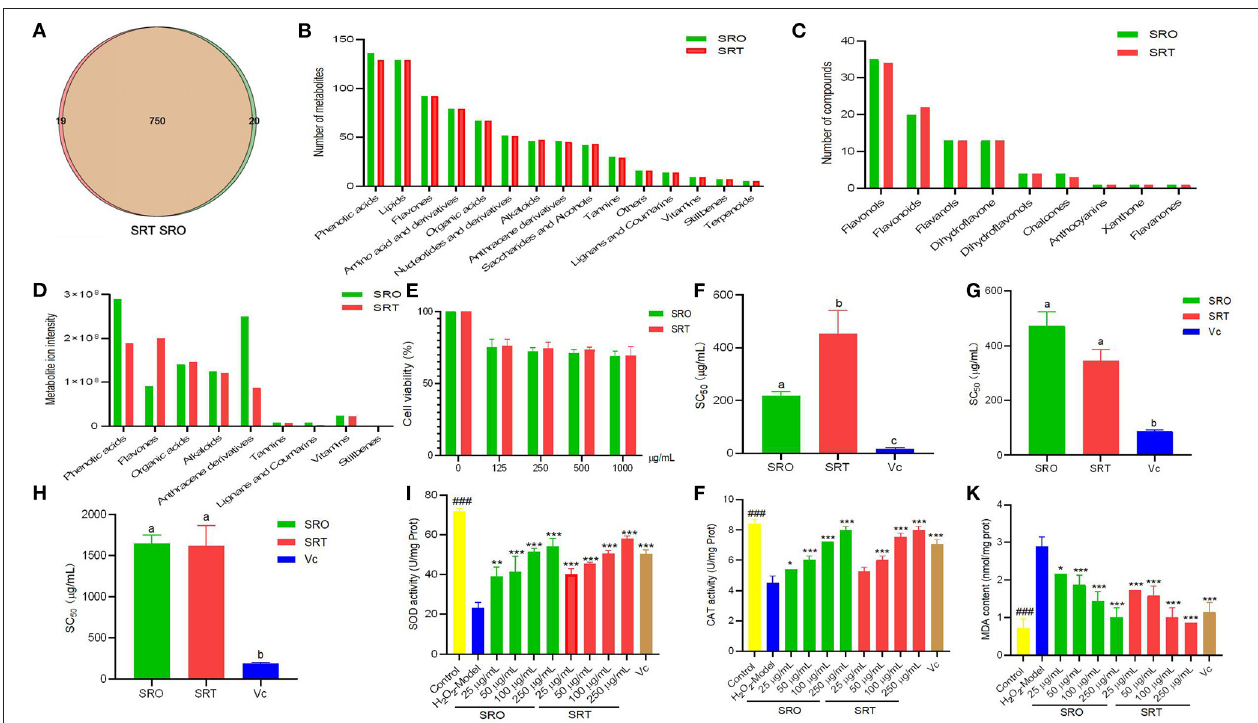
FIGURE 2 | The number of compounds (A) , metabolites (B) , and flavones (C) in SRO and SRT, and the metabolite ion intensity of secondary in SRO and SRT (D) ; the cell viability (E) ; SC 50 values for DPPH radical scavenging activity (F) , hydroxyl radical scavenging activity (G) , and superoxide radical scavenging activity (H) ; the SOD activity (I) , CAT activity (J) , and MDA content (K) in RAW264.7 cells induced by H 2 O 2 [For (F–H) , the different letter represents the significant difference, p < 0.05; for (I–K) , ### represent the significant difference between control group and model group, p < 0.001; * p < 0.05 represent the significant difference between model group and drug-treated group; ** p < 0.01; *** for p <